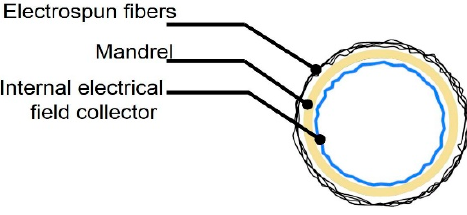
Table 2. Characteristics used for the electrospinning experiments. Figure 5. Vascular graft membrane cross-section during electrospinning process, showing location of internal electrical field collector.